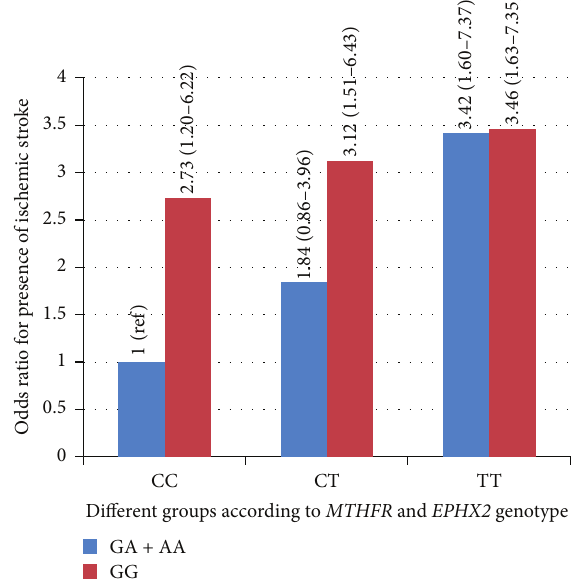
Figure 1: Risk of the combined effect of MTHFR C677T and